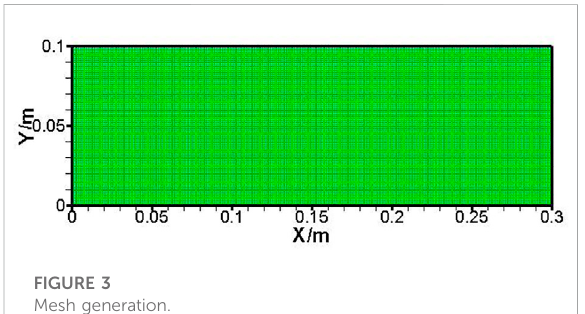
FIGURE 3 Mesh generation.